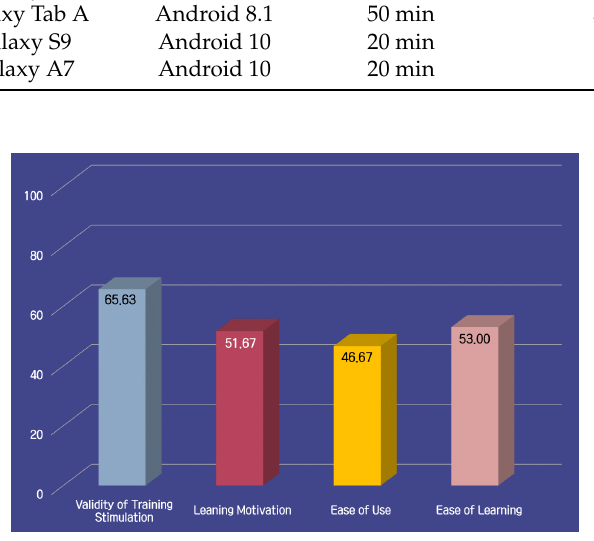
Figure 12. Results of questionnaire survey conducted with